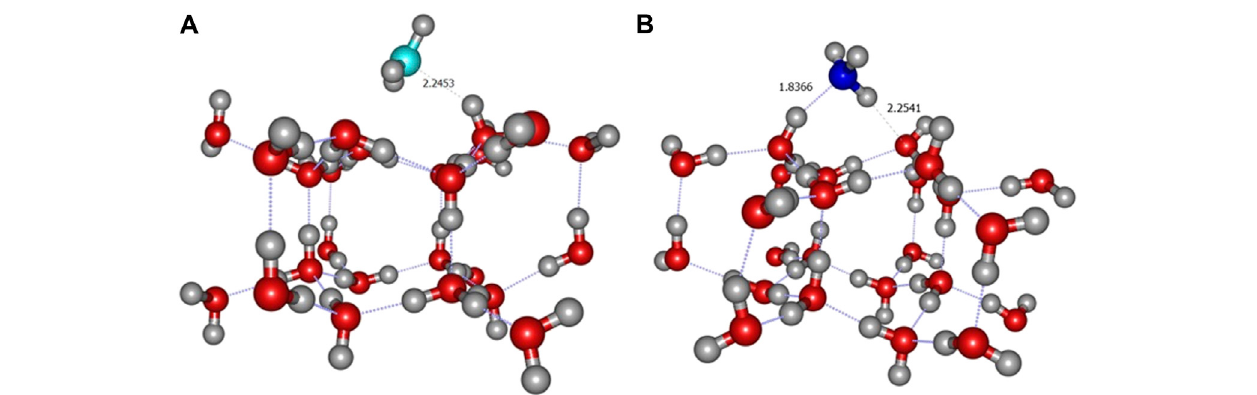
FIGURE 7 | ONIOM( ω B97X-D/6-31+G**:PM6) most stable geometry for CH 3 (A2 site) (A) and NH 3 (A3 site) (B) molecules on crystalline ice.